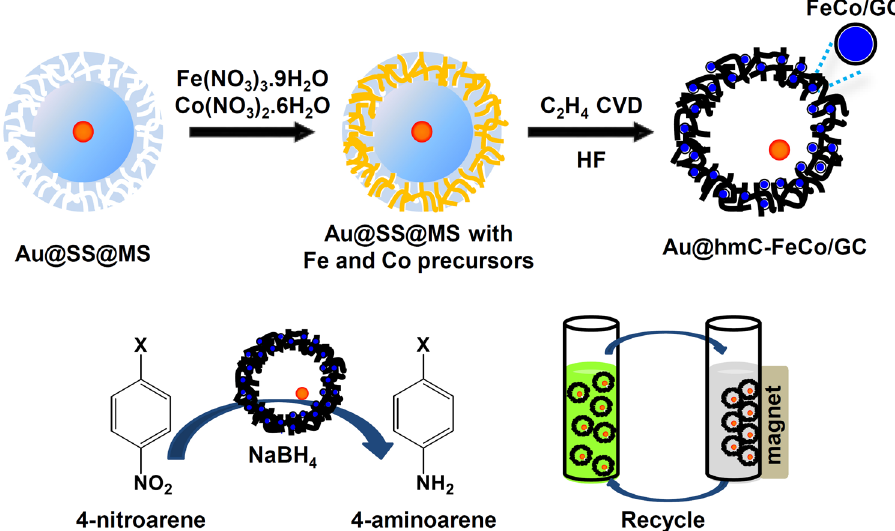
Figure 1. Schematic illustration for the preparation of Au@hmC-FeCo/GC, catalytic reduction of 4-nitroarene to 4-aminoarene by the Au@hmC-FeCo/GC, and separation of the Au@hmC-FeCo/GCs by using a